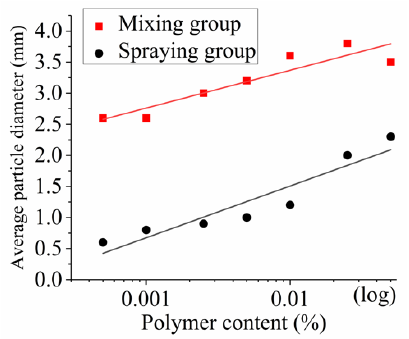
Figure 7. The relationship between the average particle diameter and polymer content.